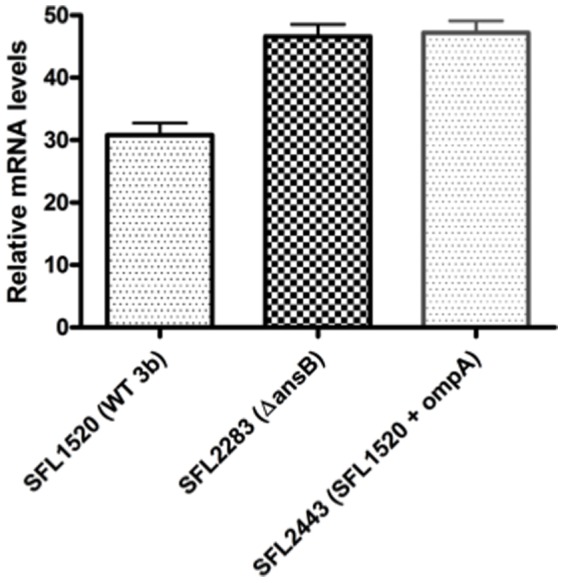
qRT-PCR analysis confirms the up-regulation of ompA in SFL2443 (wild type + ompA).qRT-PCR was used to compare the mRNA transcript levels of ompA in SFL1520 (wild type S. flexneri serotype 3b), SFL2283 (ΔansB) and SFL2443 (SFL1520 + a plasmid carrying ompA to account for the up-regulation of OmpA seen in the ΔansB mutant). Results represent the means of three biological repeats, each measured in triplicate and normalized to the control gene hisG. Error bars indicate the standard errors of the means. OmpA mRNA levels in SFL2443 are significantly higher than SFL1520 (p<0.001, unpaired t-test) and similar to the up-regulated levels seen in SFL2283 (p>0.05, unpaired t-test).